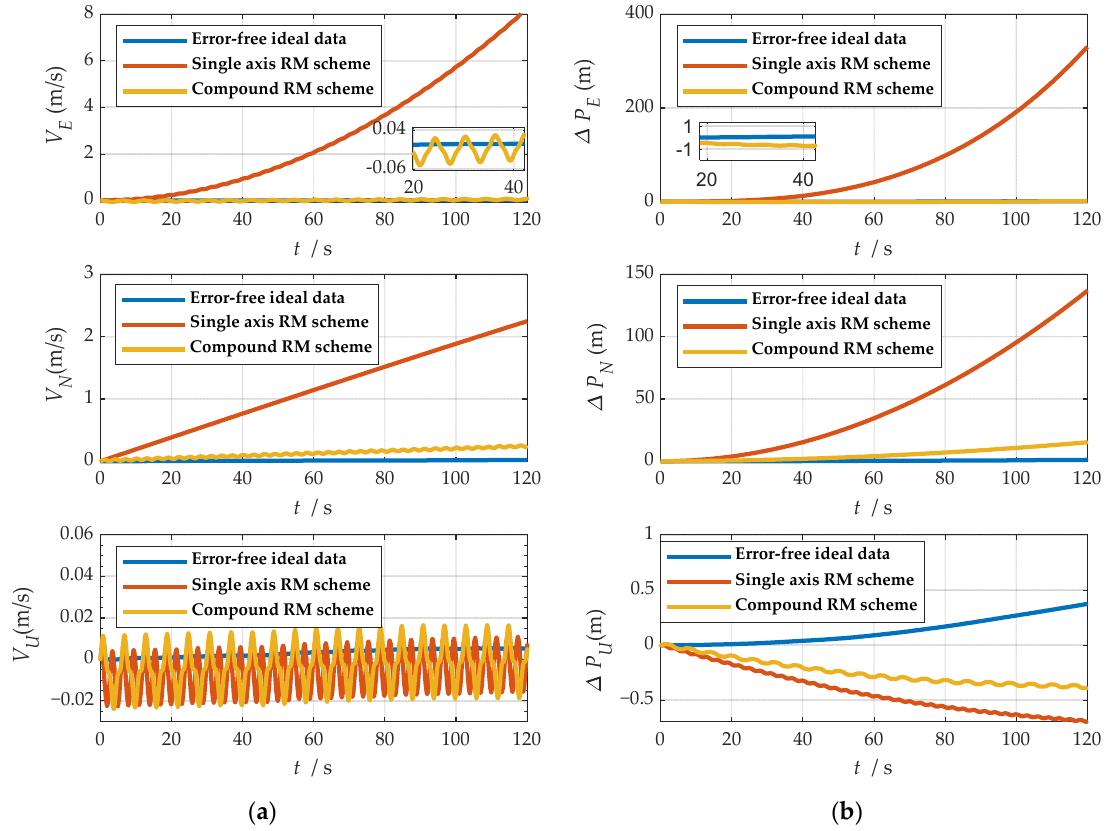
Figure 9. Comparison of velocity and position results in three directions: ( a ) comparison of velocity results in three directions; ( b ) comparison of position results in three directions.